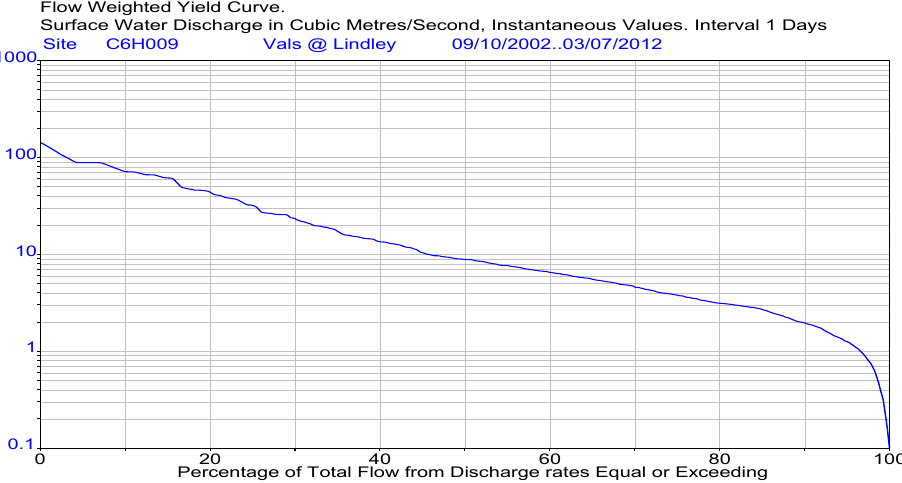
Figure 4: Time-Volume curve (Hydstra: